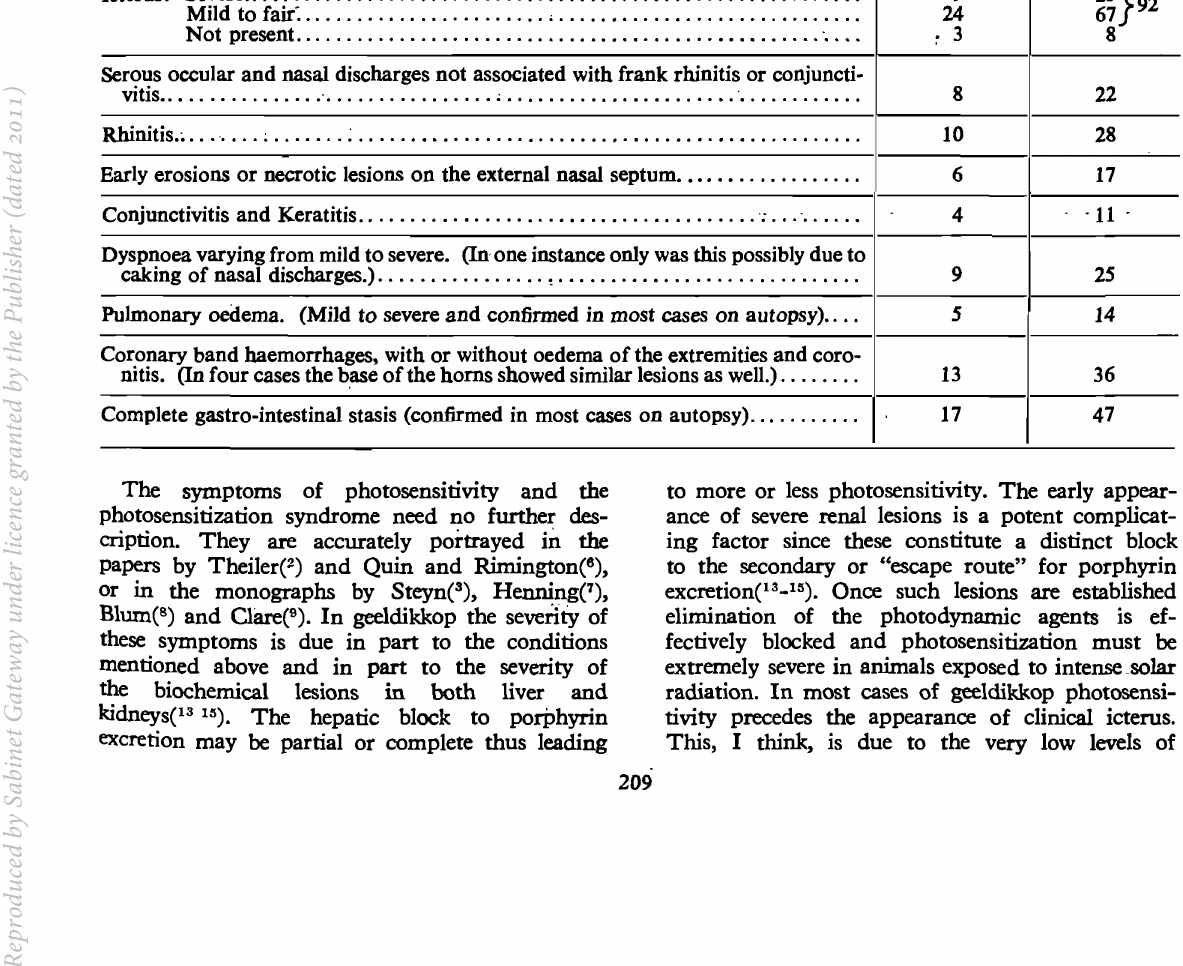
TABLE 2.-ANALYSIS OF SOME PROMINENT SYMPTOMS SEEN IN EARLY CASES OF